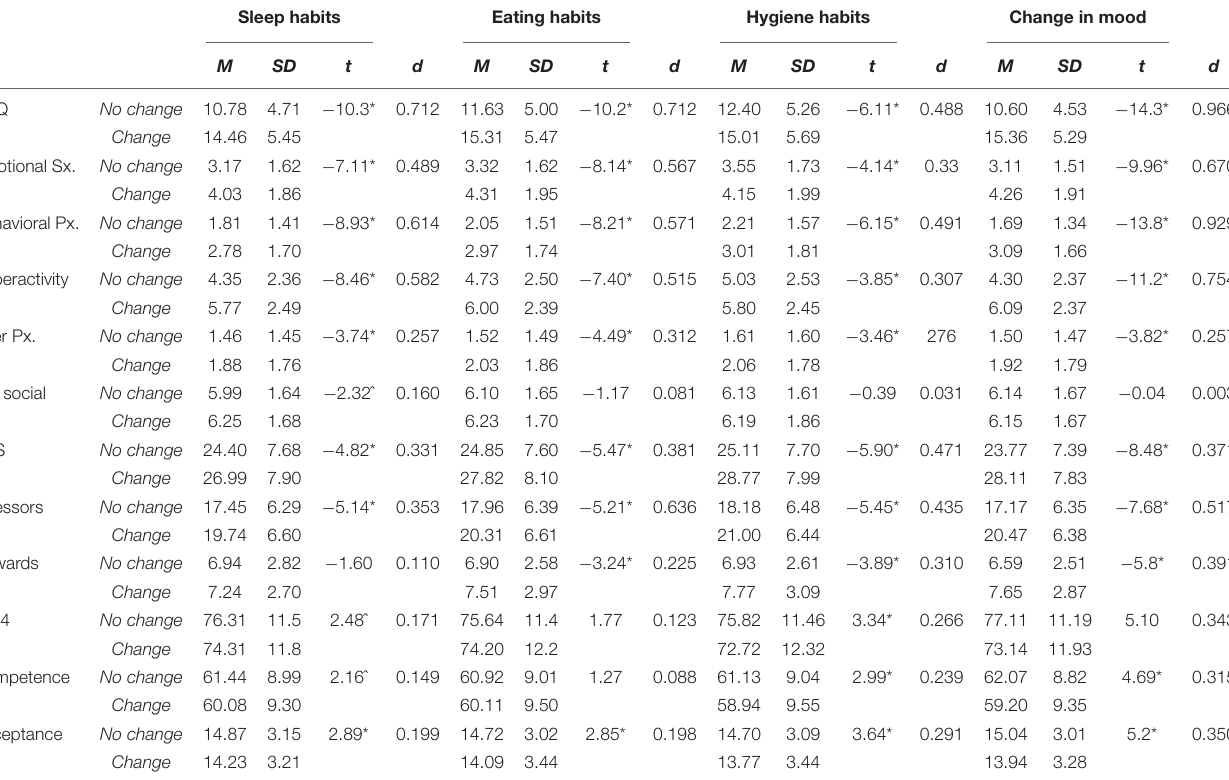
TABLE 5a | Mean scores, standard deviation and Student t to evaluate the differences in the variables according to the perception of habit change in the